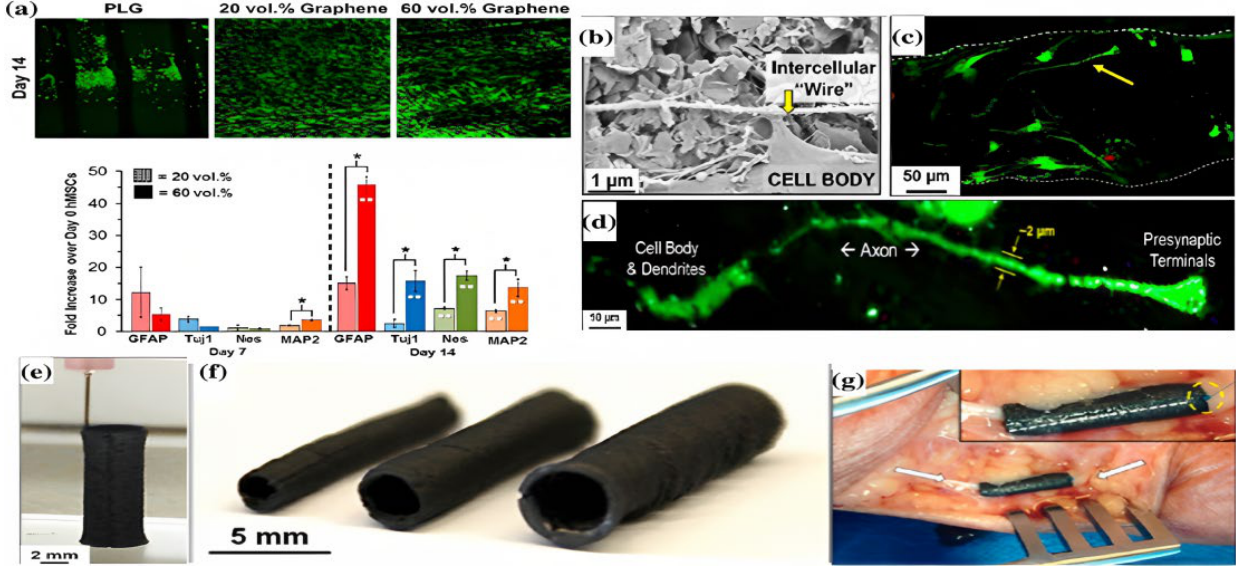
Figure 3. ( a – d ) 3D confocal reconstruction of human mesenchymal stem cells that were implanted onto different scaffolds for 14 days and marked as living (green) or dead (red). For 1, 7, and 14 days, the cells were planted onto scaffolds with 20% and 60% concentrations of graphene. The expression of the neurogenically relevant genes was altered to match that on day 0 (unseeded cells). ( e , f ) The 140-layer tubular structures were made using 3DG printing. ( g ) 3DG nerve conduit in a human cadaver. Reprinted with permission from ref. [7]. Copyright 2015 American Chemical Society.